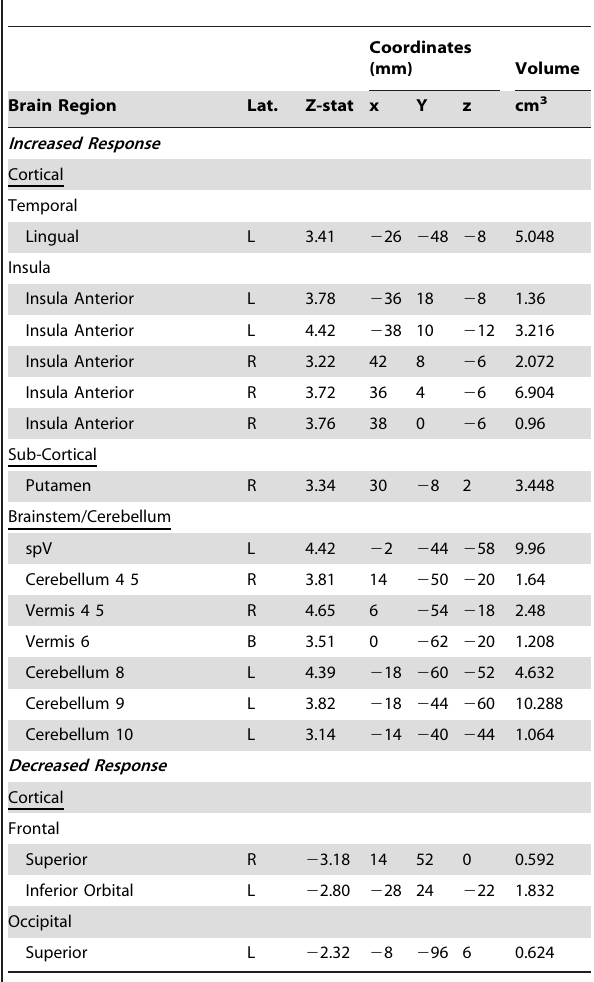
Table 2. Nalb-Nalox-induced changes in BOLD activity.